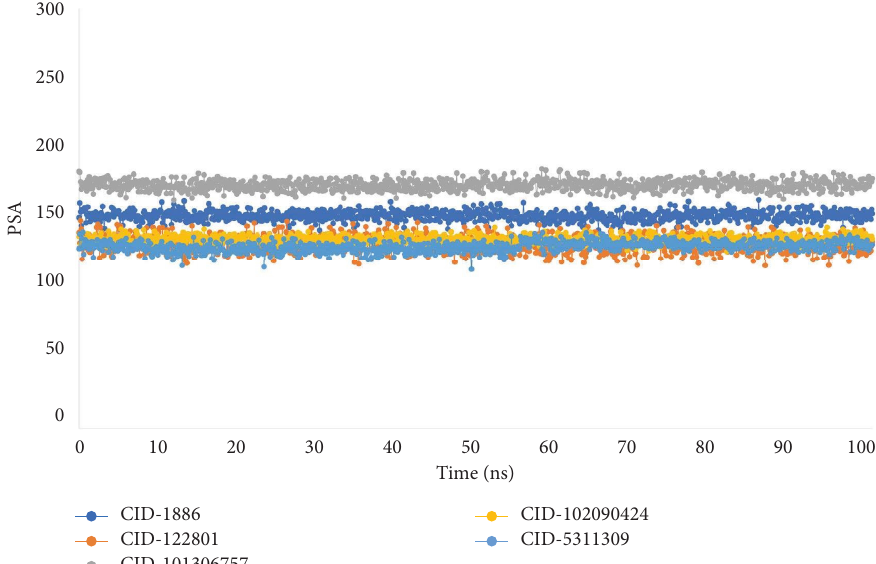
Figure 7: From the 100ns simulated interaction diagram, the polar surface area (PSA) of the protein-ligand interaction compounds was estimated. Te markers blue, orange, gray, yellow, and light blue are used to depict the selected ligand compounds CID 1886, CID 122801, CID 101306757, CID 102090424, and CID 5311309, respectively, in association with the